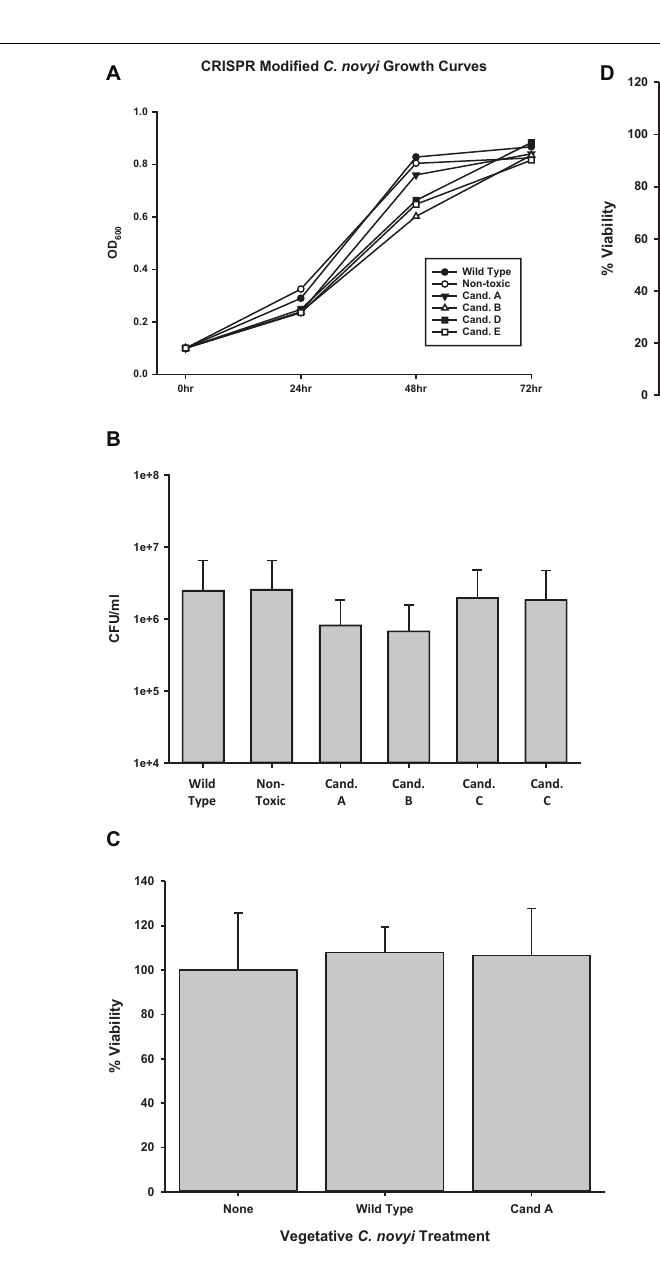
FIGURE 6 | Determining off-target effects of CRISPR/Cas9 mediated gene editing. (A) Growth curves were determined by observing candidates A–E were for 72 h collecting OD600 at significant time points. No statistical difference was determined at any time point ( n = 3 for each time point, Holms-Sidak test, p = 0.056). (B) Spore enumeration was conducted for genetically modified candidates and compared to non-modified wild-type and non-toxin C. novyi strains. No statistical difference was determined at any time point ( n = 3 for each strain, Holms-Sidak test, p = 0.058). Cell lysis was determined under both (C) aerobic and (D) anaerobic conditions by applying vegetative C. novyi wild-type, nontoxic, candidate a, and non-toxic candidate a to PANC-1 cells (No statistical significance was determinedby Holms-Sidak test n = 9 for each group, normalized to untreated